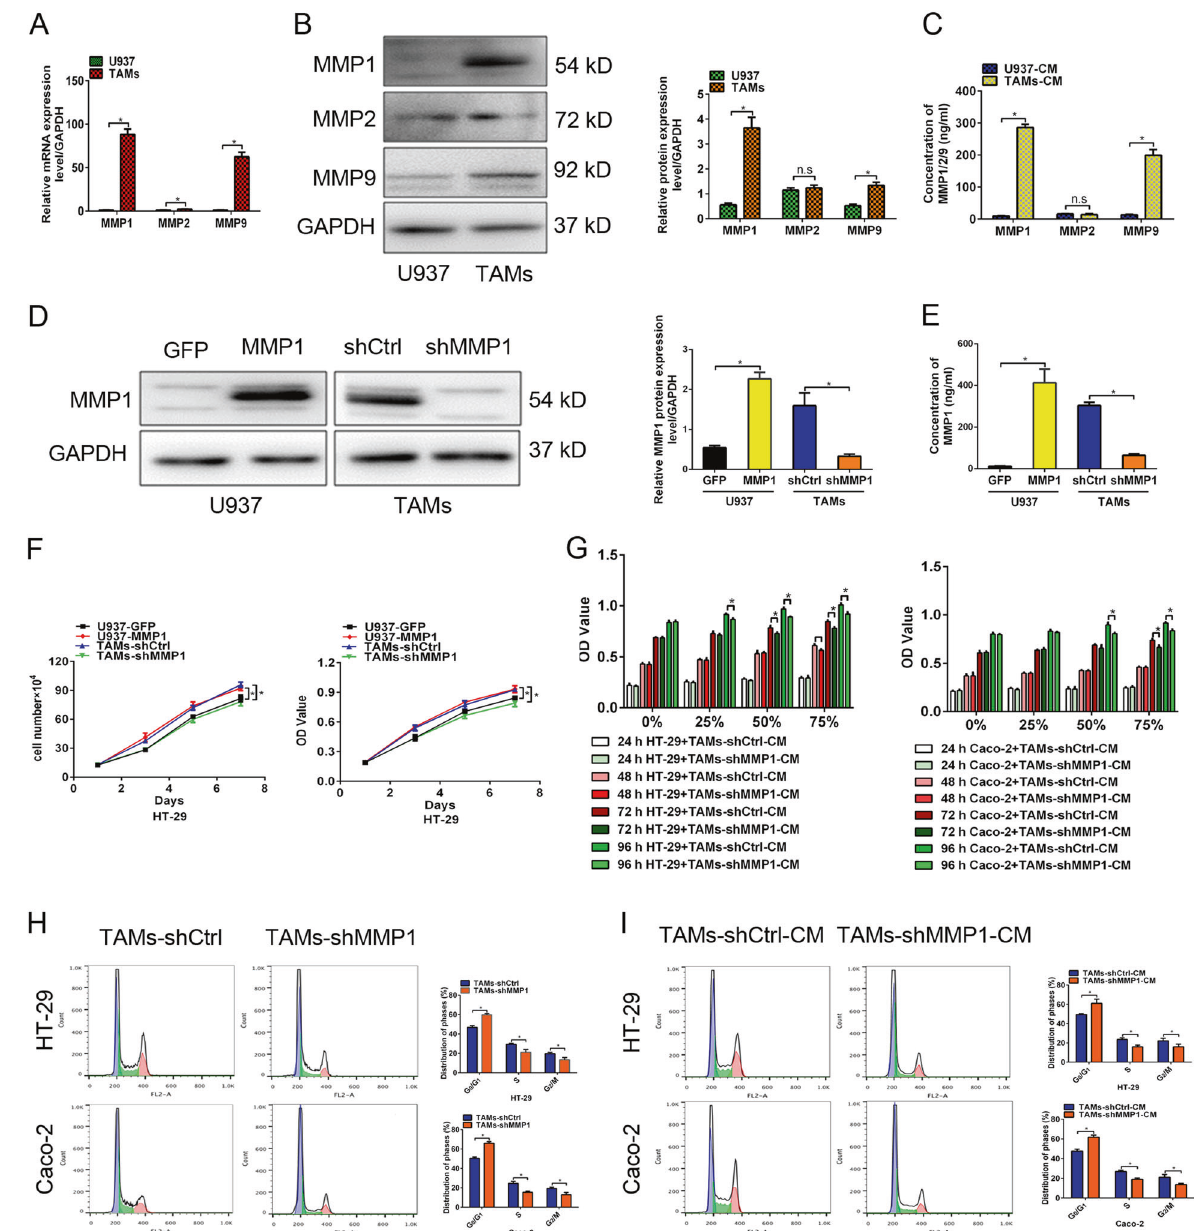
Fig. 2 MMP1 contributed to the proliferation of colon cancer cells by accelerating the cell cycle transition from G0/G1 to S and G2/M phase. A Comparison of the mRNA levels of MMP1/2/9 between U937 cells and TAMs by RT-PCR. B Comparison of the protein levels of MMP1/ 2/9 between U937 cells and TAMs by western blotting analysis. C The release of MMP1/2/9 in U937 cells and TAMs detected by ELISA assay. D Western blotting analysis for MMP1 in MMP1-overexpressing U937 cells or MMP1-knockdown TAMs. E The release of MMP1 in MMP1- overexpressing U937 cells or MMP1-knockdown TAMs detected by ELISA assay. F The effect of co-culture with TAM-shMMP1 or U937-MMP1 on the growth and viability of HT-29 cells. G HT-29 and Caco-2 cells were treated with 0, 25, 50, and 75% TAMs- shMMP1-CM for different time. The effect of treatment with TAMs-shMMP1-CM on the viability of HT-29 and Caco-2 cells was detected by cell viability assays. H , I The effect of co-culture with TAMs-shMMP1 ( H ) or treatment with TAMs- shMMP1-CM ( I ) on the cell cycle distribution of HT-29 and Caco-2 cells detected by FACS analysis. All data are presented as the mean ± SD from three independent experiments. * P < 0.05.